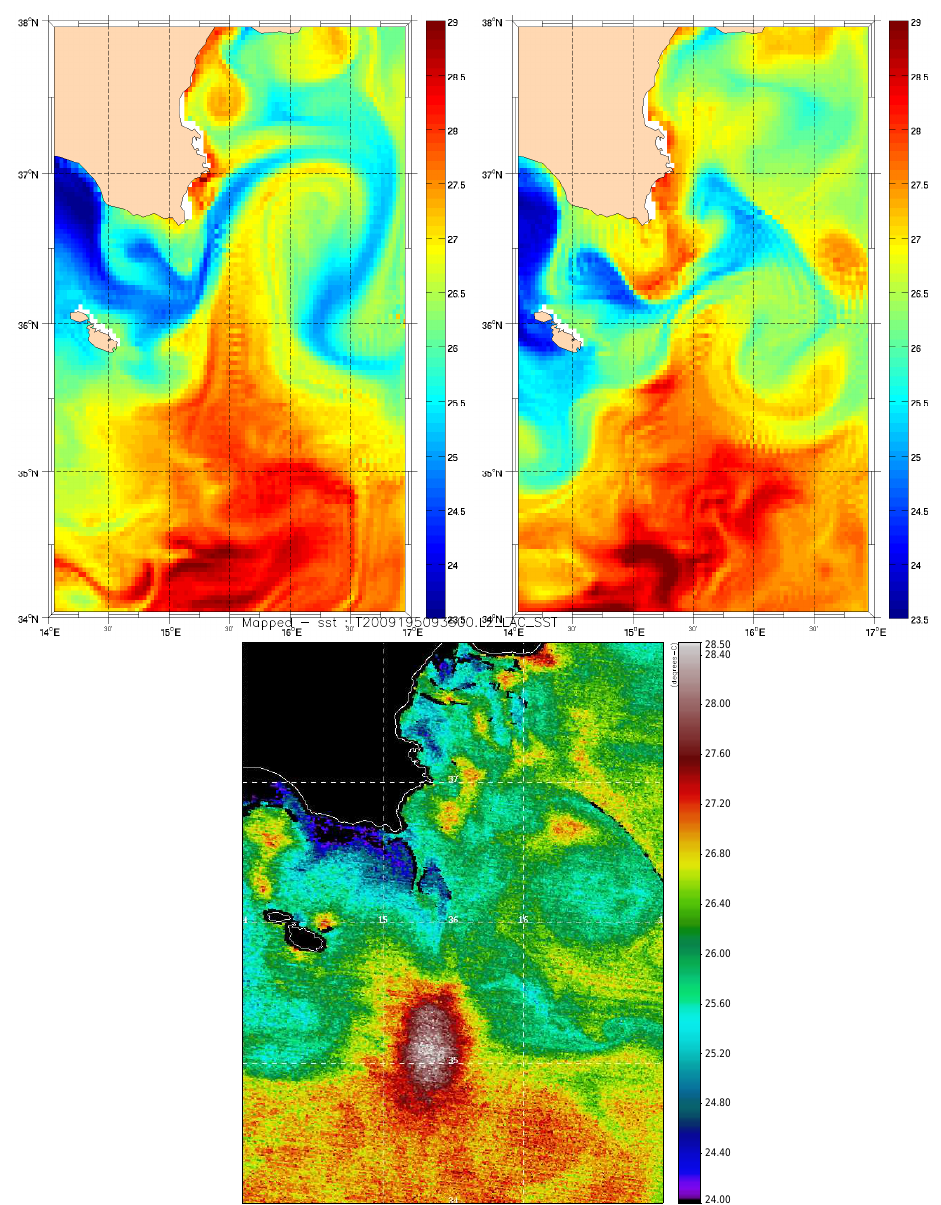
Fig. 6. 14 July 2009. SST (C ◦ ) for SIM (left) and AN (right). Bottom panel shows satellite Fig. 6. July 14 th , 2009. SST (C ◦ ) for SIM (left) and AN (right). Bottom panel shows satellite SST.